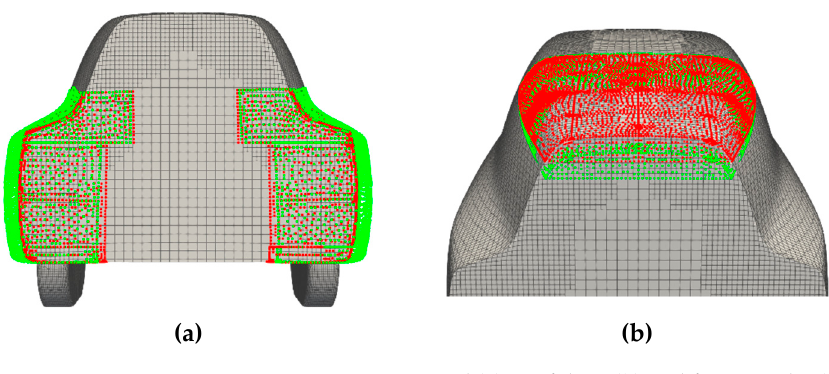
( b ) Figure 5. Dimension of the ASMO numerical domain ( a ) and details of the grid ( b ). The analyses were performed with an inlet flow velocity of 50 m/s. A segregated flow solver and a two-equations k- ε turbulence model have been employed. The convection scheme was the second-order upwind. Wall functions were adopted to model the bound- ary layer. Two optimization objectives were defined: the minimization of the total drag coefficient of the vehicle and the maximization of the downforce (identified by the inverse of the lift). A DoE (Design of Experiments) table, populated with 25 design points selected adopting an Optimal Space-Filling algorithm [37], was generated. The parameters of the design points are reported in Appendix A in Table A1. Figure 6 reports the solutions of the analyses. The drag is reported in the abscissa and the lift in the ordinate. The non-dominated solutions, representing the Pareto front, among which to select the optimum compromise, are reported in green, while the baseline solu- tion is represented by a red circle. Two solutions that improve the performance both in terms of drag and lift are identifiable and are indicated by the two arrows in Figure 6. The one with the lowest drag was selected as the optimum solution.